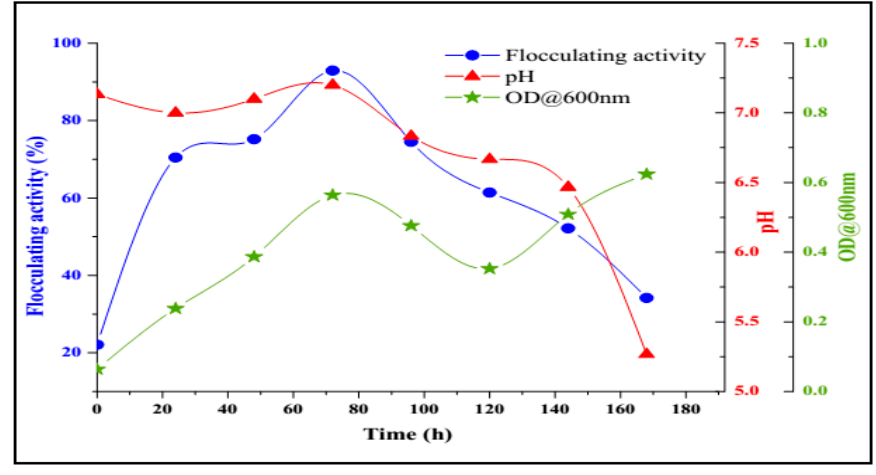
Figure 7. Time course of bioflocculant production by Bacillus salmalaya 139SI.